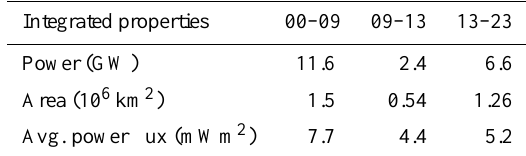
of the uncertainties in our Poynting flux data have been obtained using the magnetic field and ion drift meter data from the DMSP F-13 and F-15 satellites. For 11 March 2000, DMSP F-15 passed 60 ◦ geomag- netic latitude at 20:30 MLT and tracked across to 60 ◦ at 09:30 MLT. The perturbation magnetic field data obtained along the DMSP F-15 track are compared with the